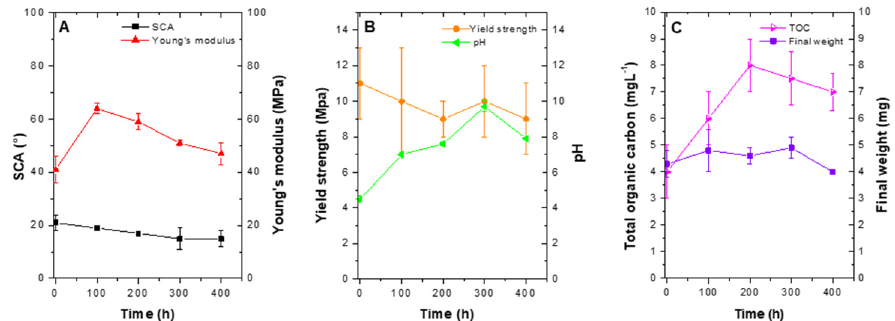
Figure 7. Photocatalytic transformation curves after 400 h of treatment. ( A ) SCA and Young´s modulus. ( B ) Yield strength and pH y. ( C ) Total organic carbon and final weight. (Treatment conditions: 1 g L − 1 TiO 2 and pH 4.5).